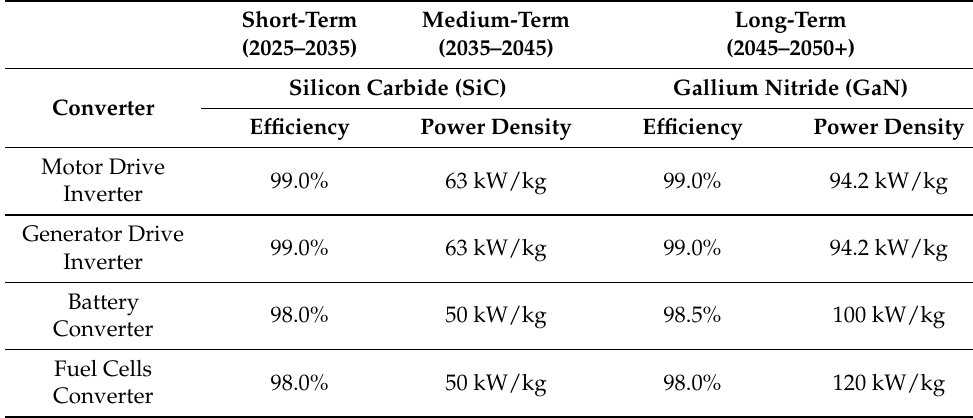
Table 4. Technology characteristics of power